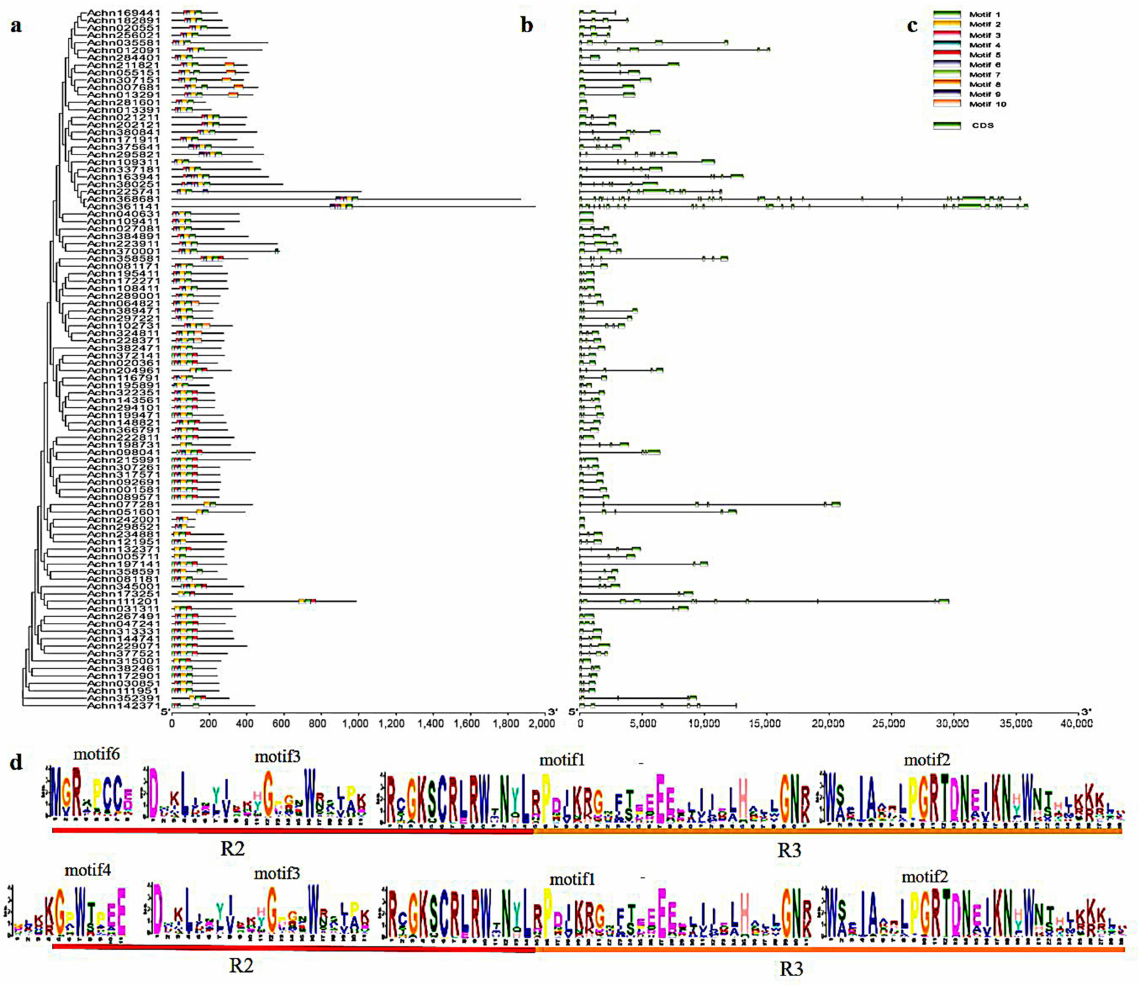
Figure 3. Subgroups of AcR2-MYB and AcR3-MYB genes in kiwifruit ( a ) protein evolution analysis, ( b ) conservative motif analysis, ( c ) gene structure analysis and ( d ) conservative domain sequence.